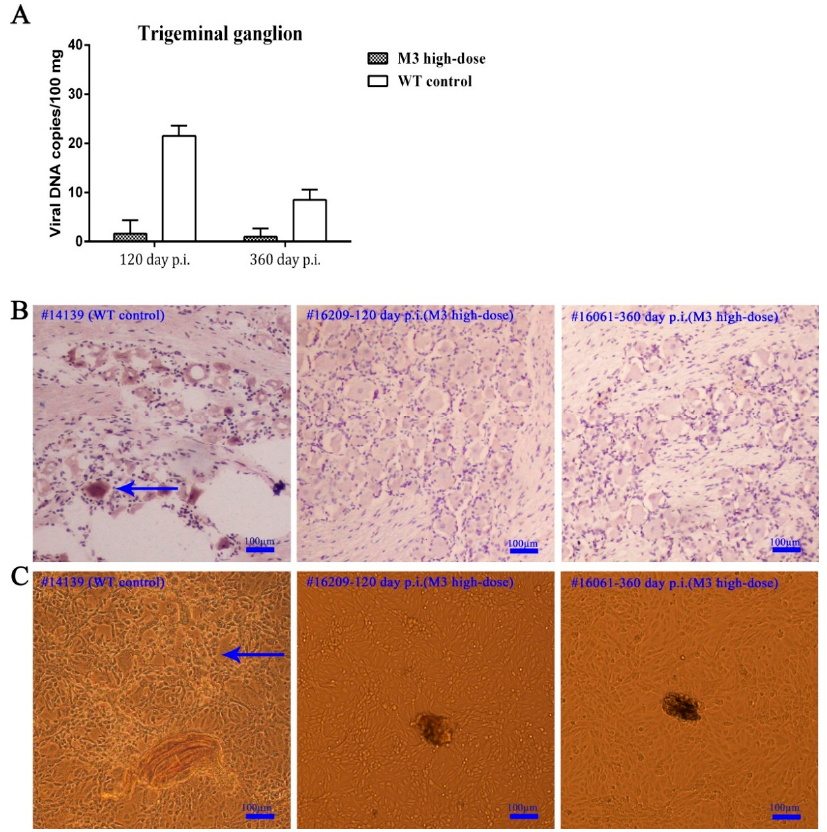
Figure 3. The detection of the M3 latent infection in the TG of inoculated macaques. ( A ) M3 distribution in the TG of macaques from the high-dose group (#16209 and #16061) and the WT control macaques (#14139) on days 120 and 360, post-immunization. ( B ) The in situ hybridization of the TG of WT control macaques (#14139) and macaques from the high-dose group on days 120 (#16209) and 360 (#16061) using a specific LAT mRNA probe. Positive in situ hybridization results are indicated by the arrows; scale bars = 100 μ m. ( C ) The co-culture of Vero cells with the TG of WT control macaques (#14139) and macaques from the high-dose group on days 120 (#16209) and 360 (#16061). A CPE is indicated by the blue arrows; scale bars = 100 μ m.